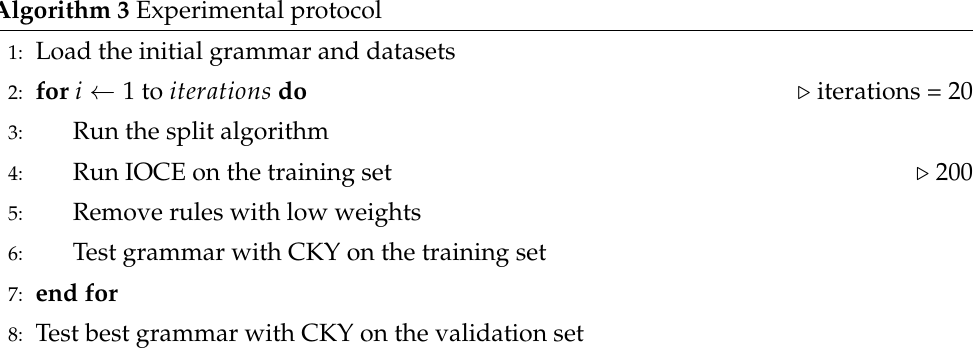
Algorithm 3 Experimental